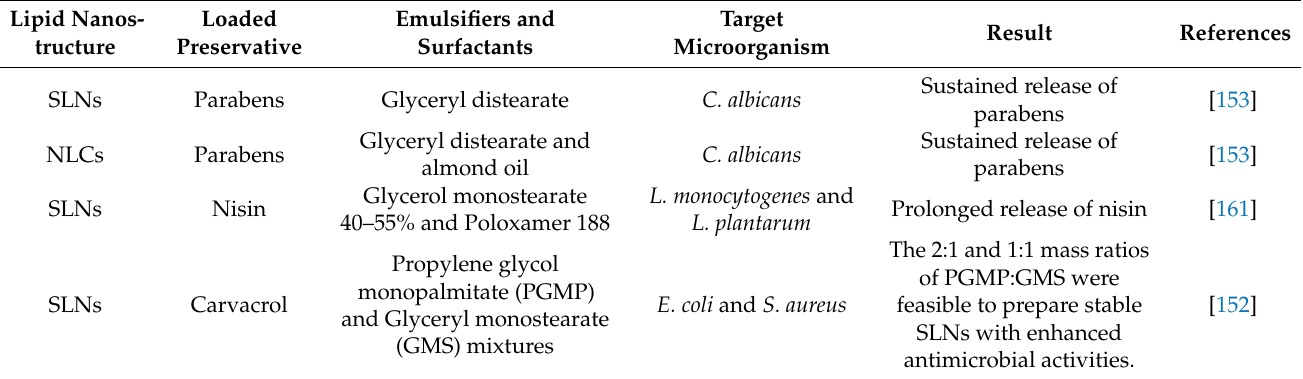
Table 6. Applications of SLNs and NLCs in cosmetics and food